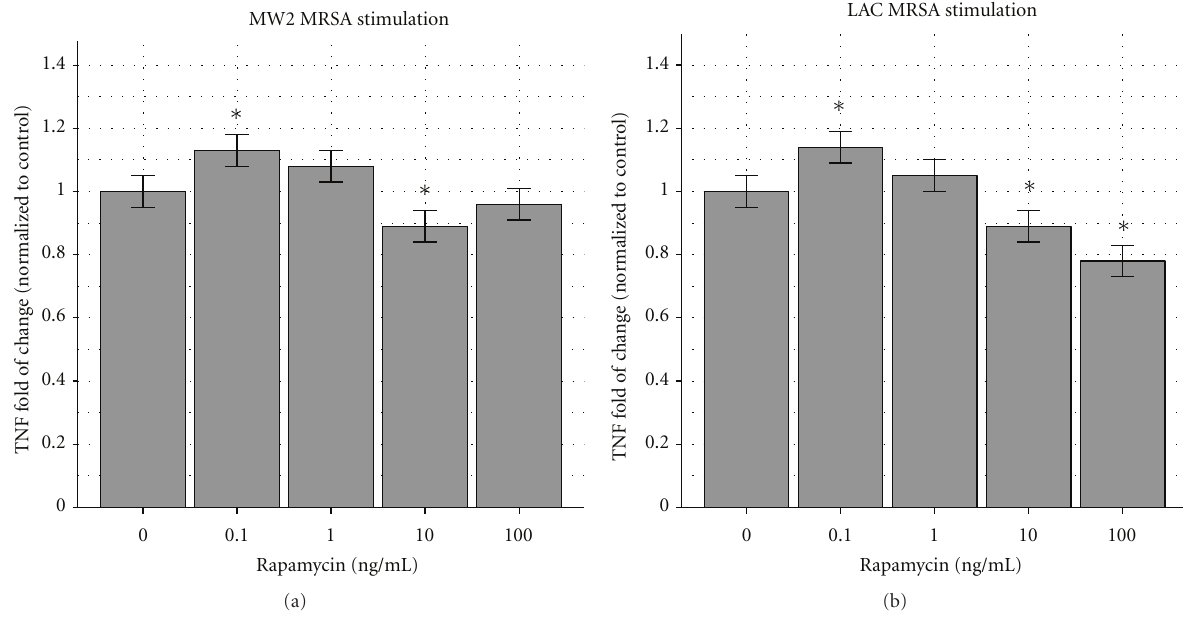
Figure 2: (a) E ff ects of rapamycin on RAW264.7 murine macrophages stimulated by MW2 MRSA. The MW2 (USA400) MRSA strain stimulated more TNF secretion by RAW264.7 murine macrophages when exposed to rapamycin at concentrations of 0.1 and 1 ng/mL and less when exposed to rapamycin at 10 and 100ng/mL. The response at 0.1 ng/mL (second column) and 10ng/mL (fourth column) represented an increase of 13% and a decrease of 11%, both significantly di ff erent ( P < 0 . 05) from the untreated control (first column). The responses at 1ng/mL (third column) and 100 ng/mL (fifth column) were an 8% increase and 4% decrease, which were not significantly di ff erent from the control. The results are depicted as fold of change compared to the control with 95% confidence intervals shown as “error bars.” ∗ P < 0 . 05. The control response was 37,632 ± 941pg/mL. (b) E ff ects of rapamycin on RAW264.7 murine macrophages stimulated by LAC MRSA. The LAC (USA300) MRSA strain stimulated more TNF secretion by RAW264.7 murine macrophages when exposed to rapamycin at 0.1 and 1ng/mL and less when exposed to rapamycin at 10 and 100 ng/mL. The response at 0.1 ng/mL (second column) had an increase of 14%, significantly di ff erent ( P < 0 . 05) from the untreated control (first column). The response at 1 ng/mL (third column) presented an increase of 9%, which did not reach statistical significance. The responses at 10 ng/mL (fourth column) and 100 ng/mL (fifth column) demonstrated decreases of 11% and 22%—significantly di ff erent from the control at P < 0 . 05. The results are depicted as fold of change compared to the control with 95% confidence intervals shown as “error bars.” ∗ P < 0 . 05. The control response was 27,965 pg/mL ±